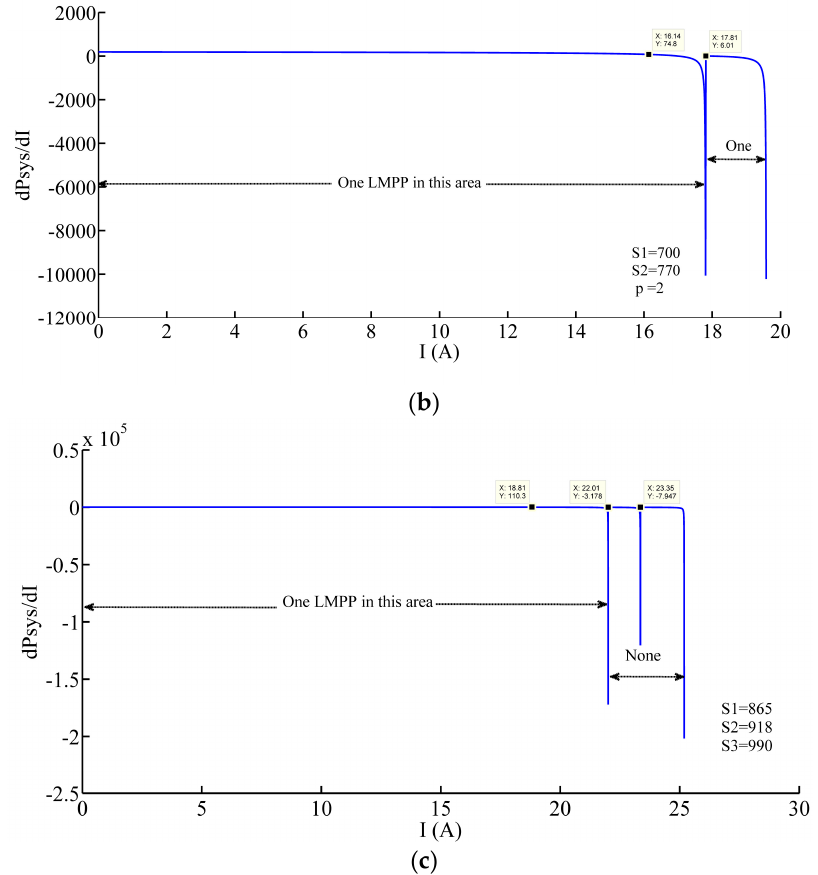
Figure 4. -I characteristic curves in different irradiance conditions in series-connected solar array PV systems; ( a , b ) in a two-array series-connected PV system; and ( c ) in a three-array series-connected PV system.